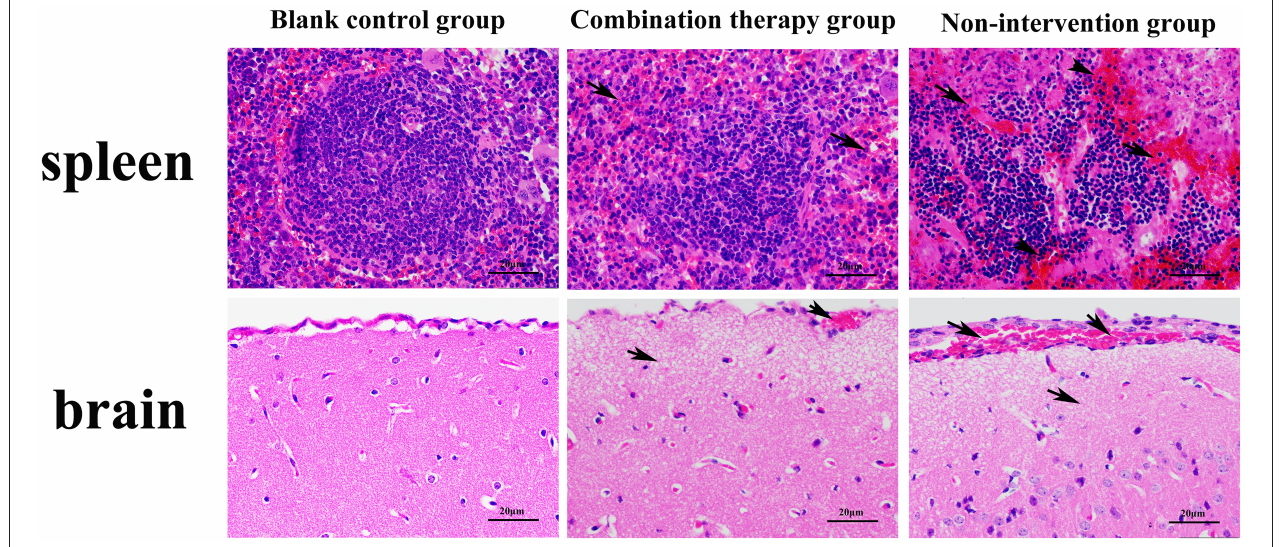
FIGURE 7 | Giemsa staining of mouse parenchyma ( × 1,000). Red arrow indicates bacteria with the typical form of LM. LM was not detected in the blank control group and non-intervention group.